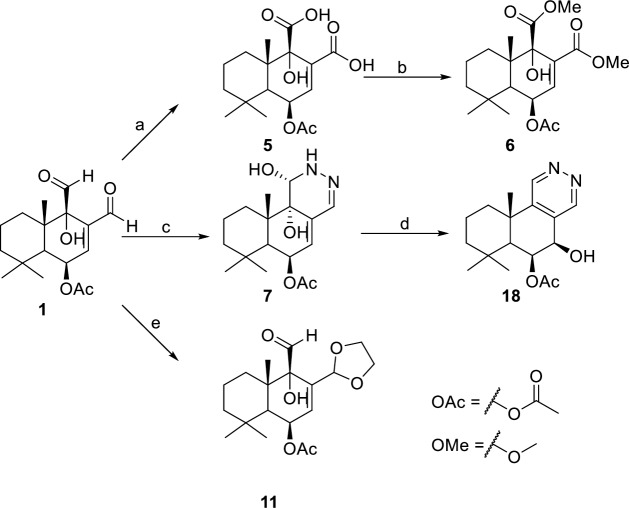
Derivatization of 1 into structural analogues.Reagents and conditions: (a) NaClO2, NaH2PO4·H2O, H2O2, MeCN, H2O, r.t., 24 h; (b) TMS-CHN2, MeOH:Et2O, 0 oC, 30 min; (c) H2N-NH2, CH2Cl2:EtOH, 2 h; (d) MeOH, r.t.; (e) HOCH2CH2OH, p-TsOH, benzene, reflux, 24 h.